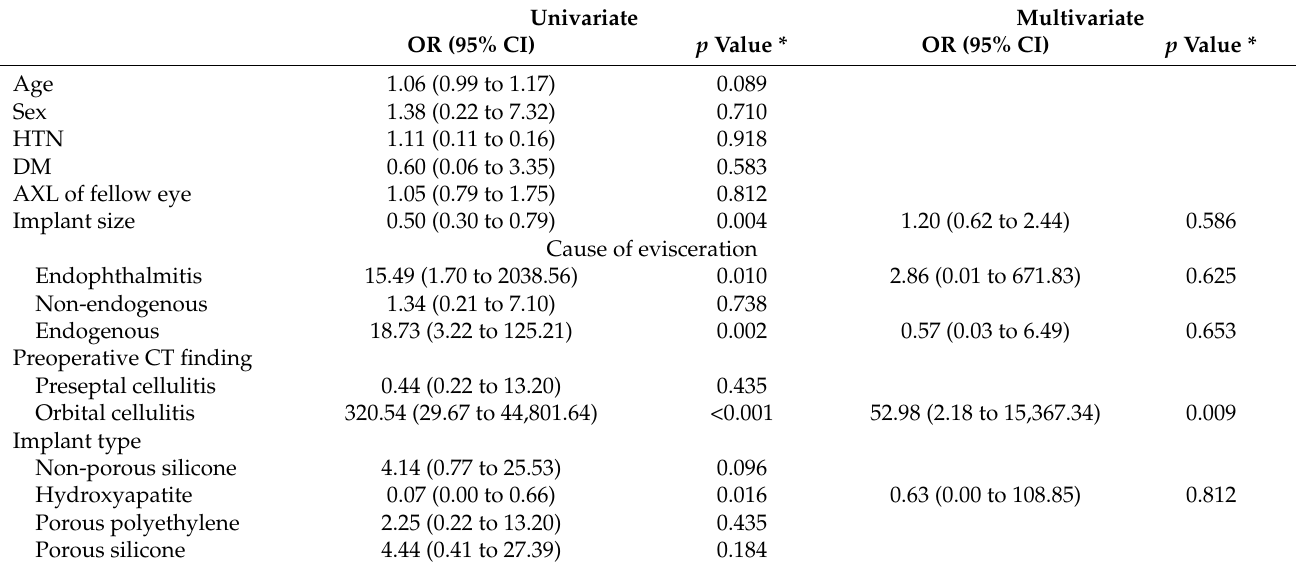
Table 3. Risk factors for orbital implant extrusion after